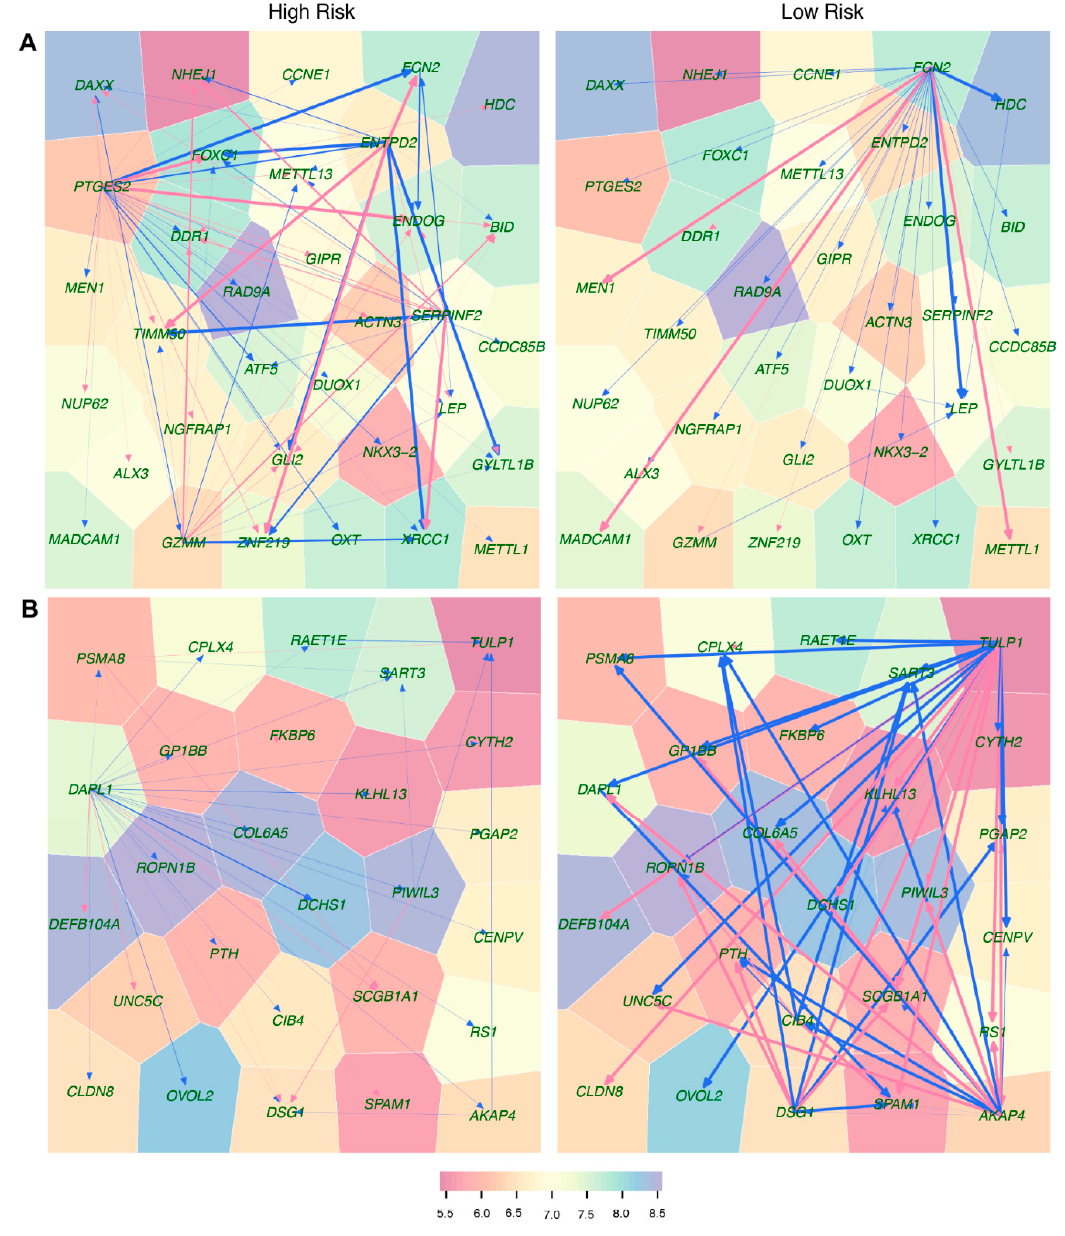
Figure 7. Voronoi treemaps that visualize fine-grained idopNetworks among genes from module 20 ( A ) and 29 ( B ) for high-risk and low-risk patients. Each polygon area (node) is represented by a gene (with its name shown), with the color metric being proportional to the overall expression level of this gene. Activation and inhibition are denoted by arrowed red and blue lines, respectively, with the thickness of lines being proportional to the strength of gene–gene interactions.